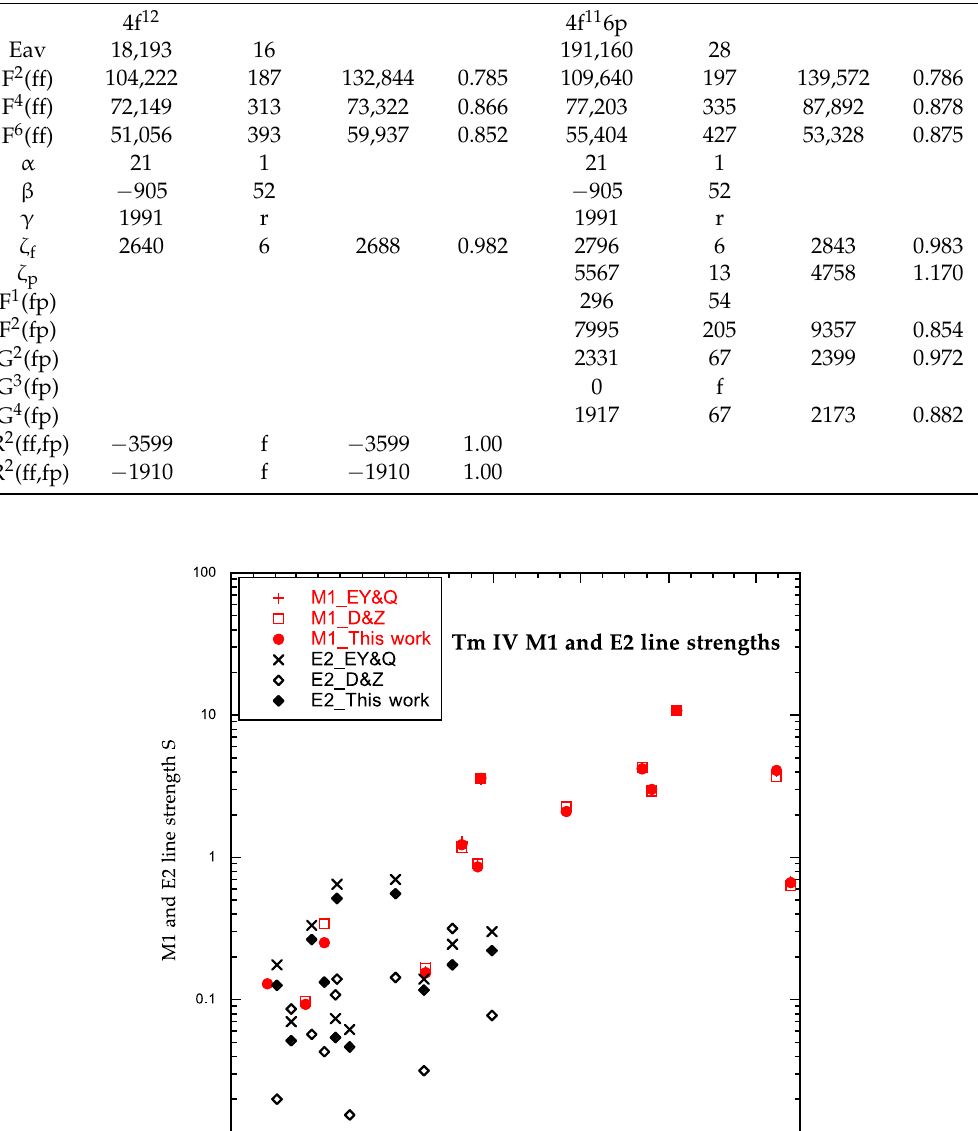
Table 1. Parameter values (in cm − 1 ) for 4f 12 and 4f 11 6p in Tm IV from a least-squares fit including four even configurations. Experimental energy values are from [11,24]. The perturbing configurations 5p 5 4f 13 and 5p 5 4f 12 6p are introduced in the basis set with all relevant parameters (scaled HFR), and E av (5p 5 4f 13 ) = 235,589 cm − 1 and E av (5p 5 4f 12 6p) = 361,860 cm − 1 fixed. The constrained parameters are indicated in the columns “St. Dev” by ‘r’ (linked by a constant ratio) and by ‘f’ (fixed). Param.